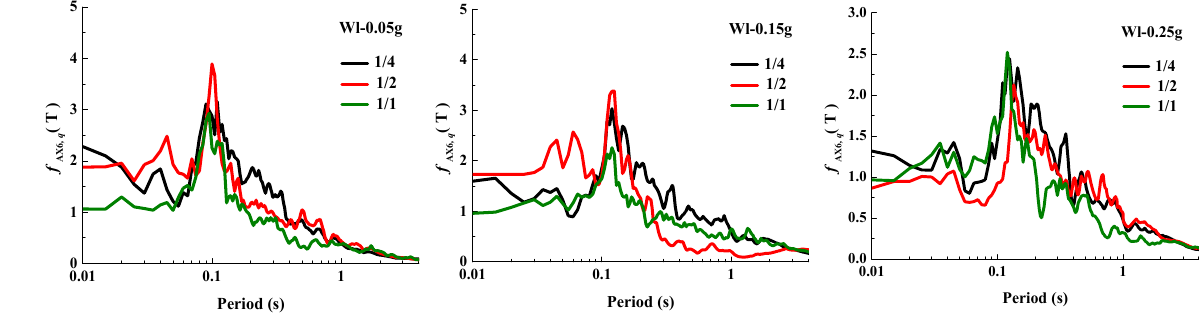
Figure 14. Transfer functions of measuring point AX6 under scaled El Centro records.